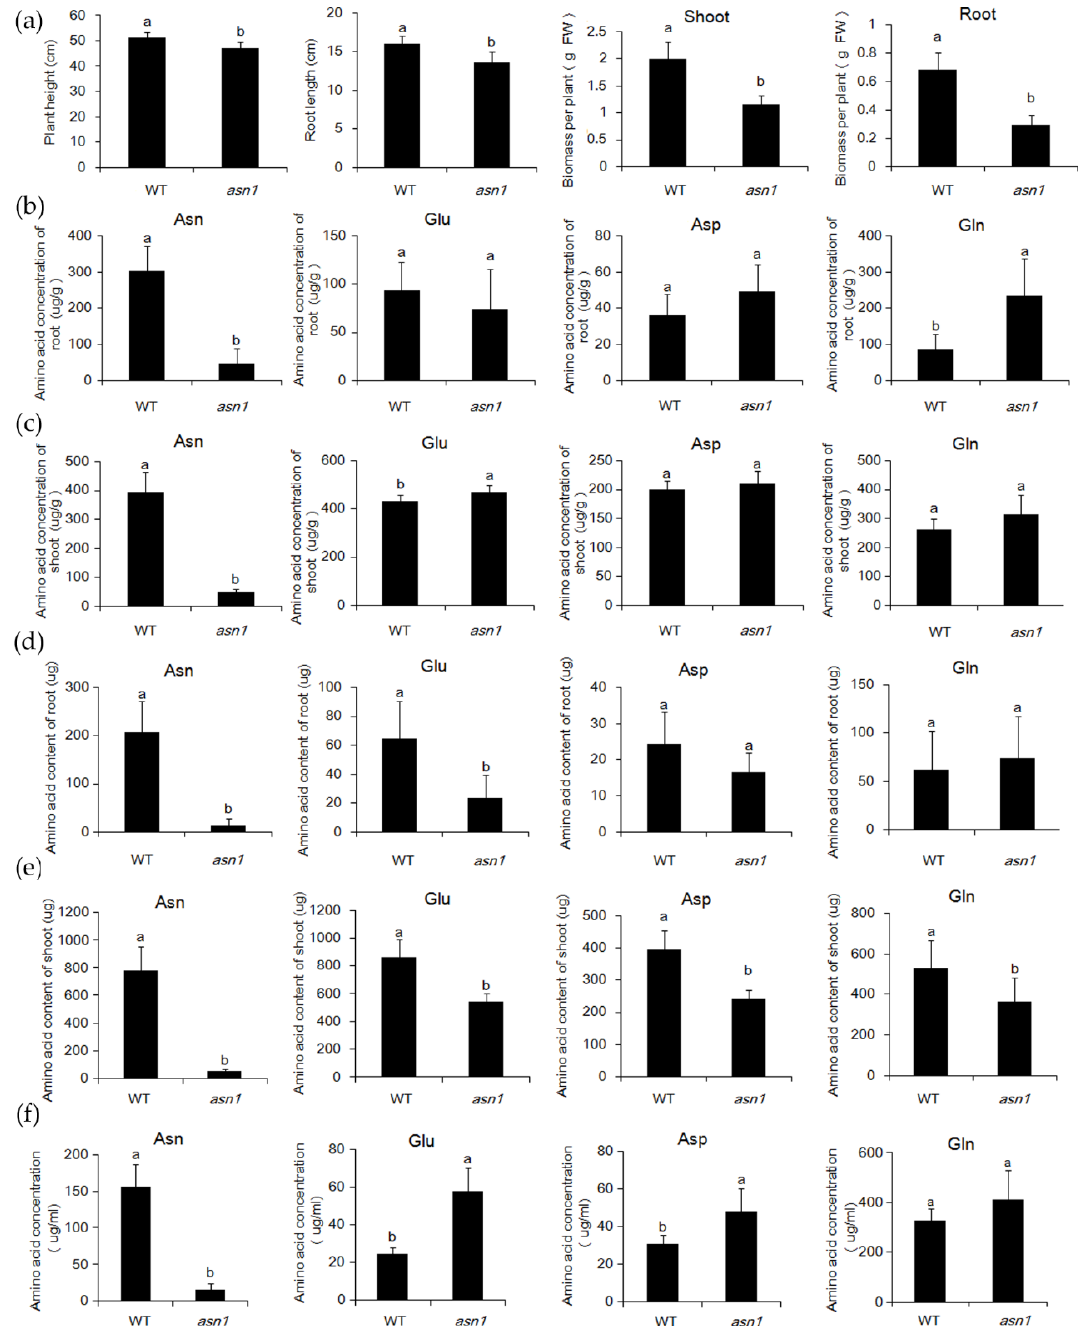
Figure 3. Comparison of asparagine, glutamate, aspartate, and glutamine in shoot, root and xylem sap of WT and asn1 . ( a ) Plant height, root length, and biomass of WT and asn1 after treatment with 2.5 mM NH 4+ for two weeks; FW, fresh weight; ( b ) concentration of asparagine (Asn), glutamate (Glu), aspartate (Asp), and glutamine (Gln) in the root of WT and asn1 ; ( c ) concentration of Asn, Glu, Asp, and Gln in the shoot of WT and asn1 ; ( d ) content of Asn, Glu, Asp, and Gln in the root of WT and asn1 ; ( e ) content of Asn, Glu, Asp, and Gln in the shoot of WT and asn1 ; ( f ) concentration of Asn, Glu, Asp, and Gln in xylem sap of WT and asn1 treatment with 2.5 mM NH 4+ for four weeks. Data are means ± SD ( n ≥ 5). Means with different letters were significantly different.